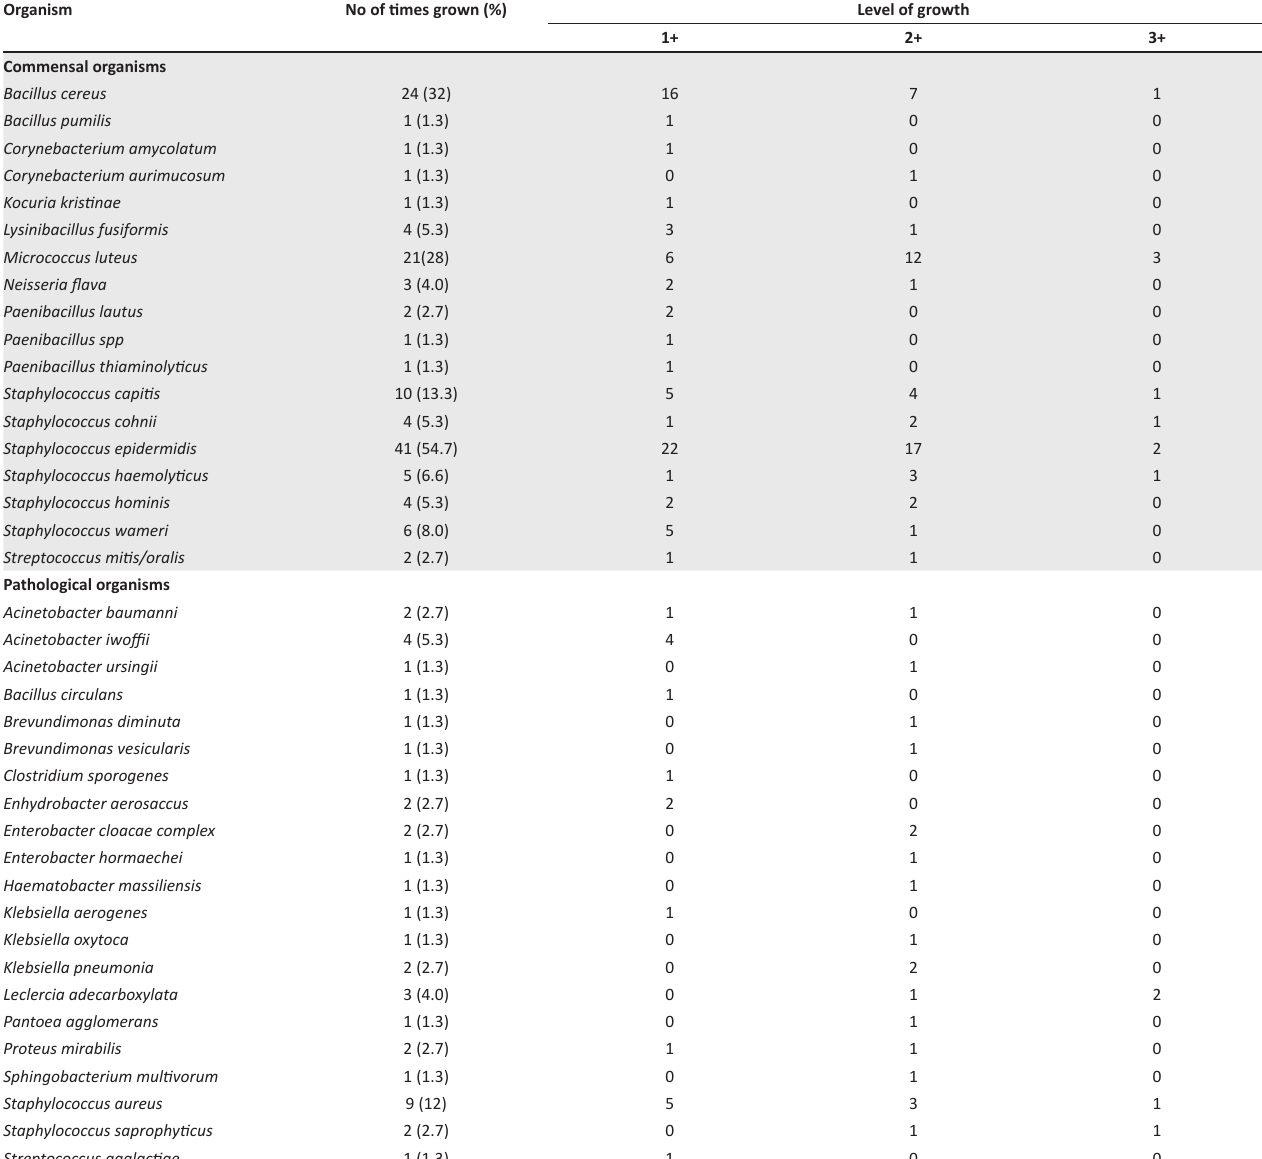
TABLE 1-A1: Identity and quantity of organisms grown.